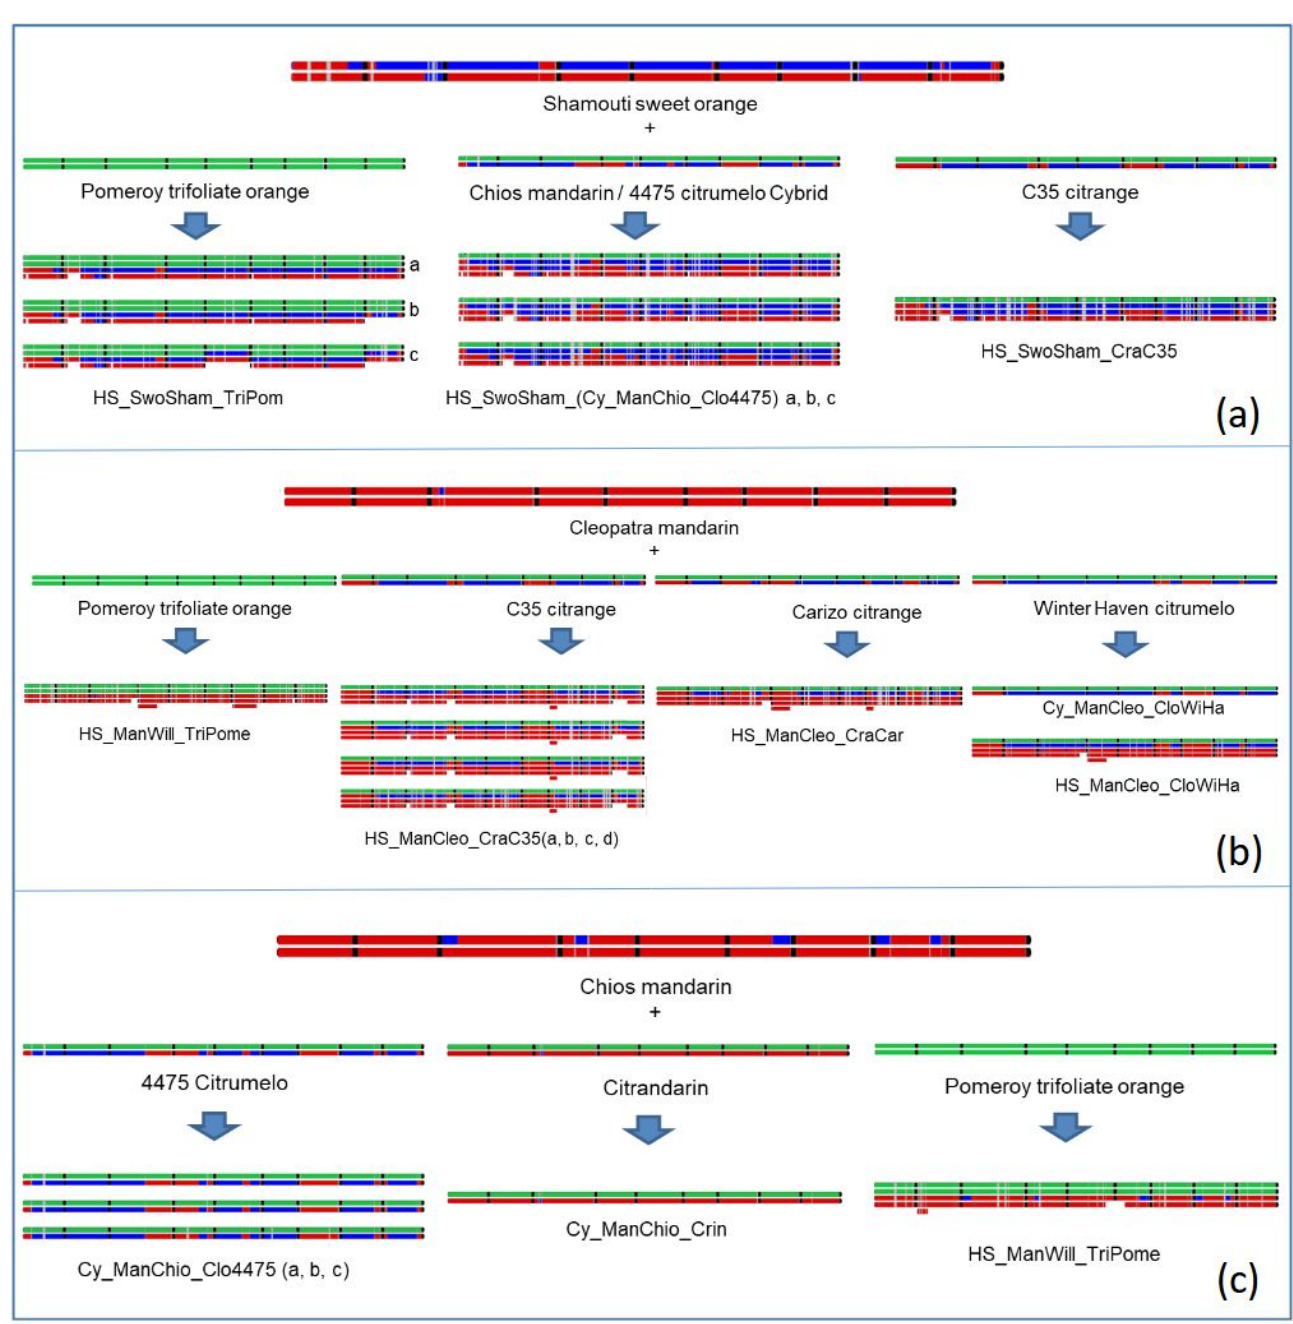
Figure 8. Phylogenomic caryotype of parents, cybrids, and nuclear somatic hybrids. Green: P. trifoliata ; red: C. reticulata ; blue: C. maxima ; grey: undetermined; black: separation between chromozomes. ( a ) combinations with Shamouti sweet orange; ( b ) combinations with Cleopatra mandarin; ( c ) combination with Chios sweet orange. The a,b,c,d letter after the code of the parental combination of somatic hybridization correspond to the different plants regenerated from a same combination and sharing the same phylogenomic pattern.